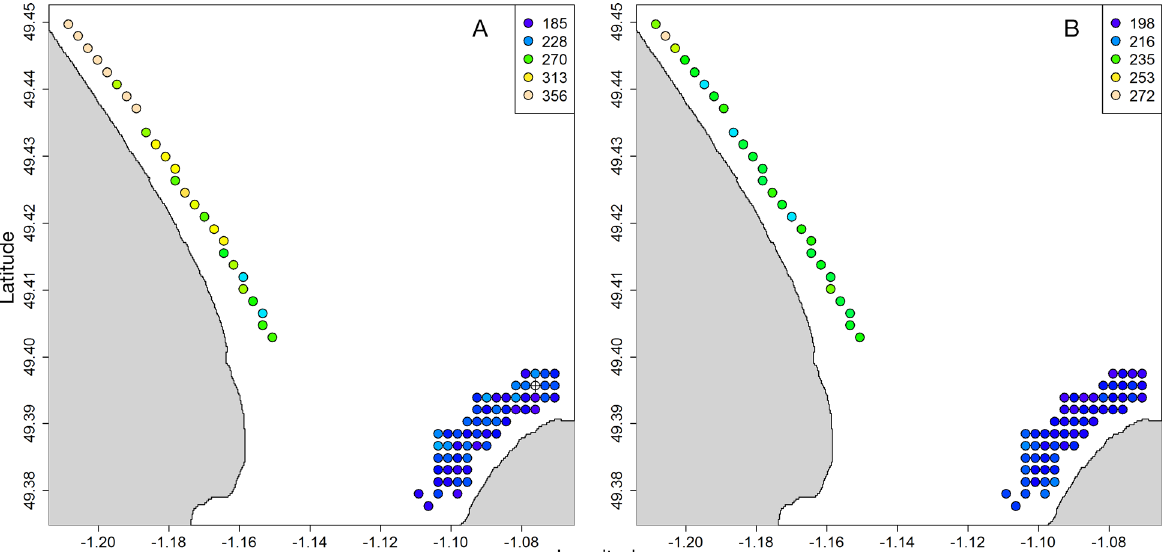
Fig. 5. Maps of the time to obtain 50% mortality ( T 50 ) in days, (A) in each patch, when oysters were initially infected in patch 78 (cross symbol), and (B) computed for simulations with different initial conditions. One simulation was run for each individ- ual patch with the oysters initially infected in this patch. T 50 of one patch refers to the population summed over all patches for that